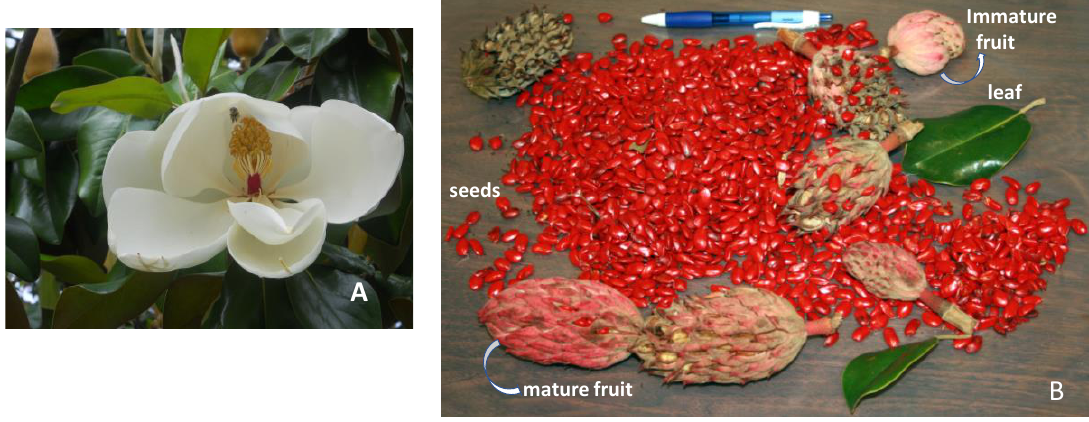
Figure 4. Study material. A : flowers; B : leaves, immature fruits, mature fruits and seeds. Photos courtesy of V.R.